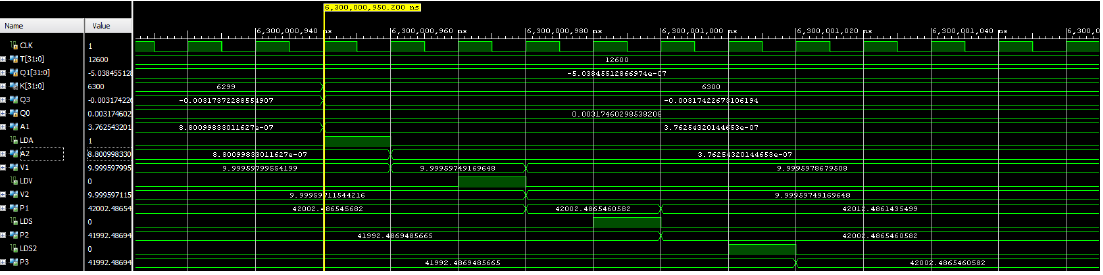
Figure A3. Registers activation for parabolic profile.